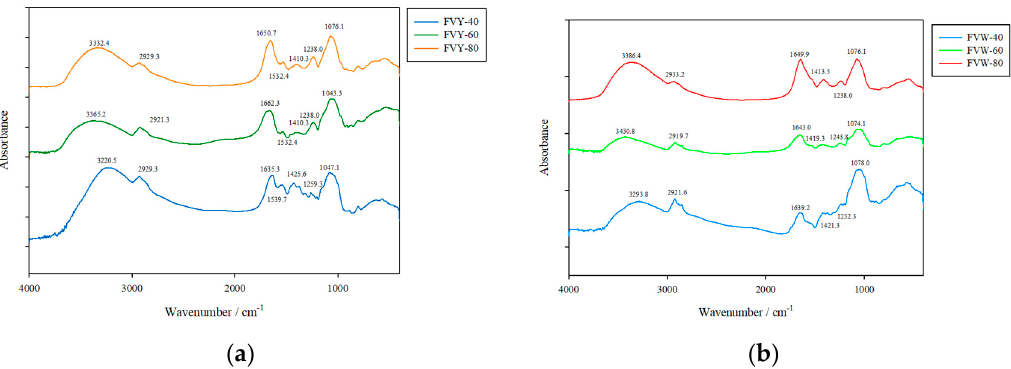
Figure 5. FT-IR spectrum of ( a ) yellow strain and ( b ) white strain polysaccharides at the range of 4000–400 cm − 1 .